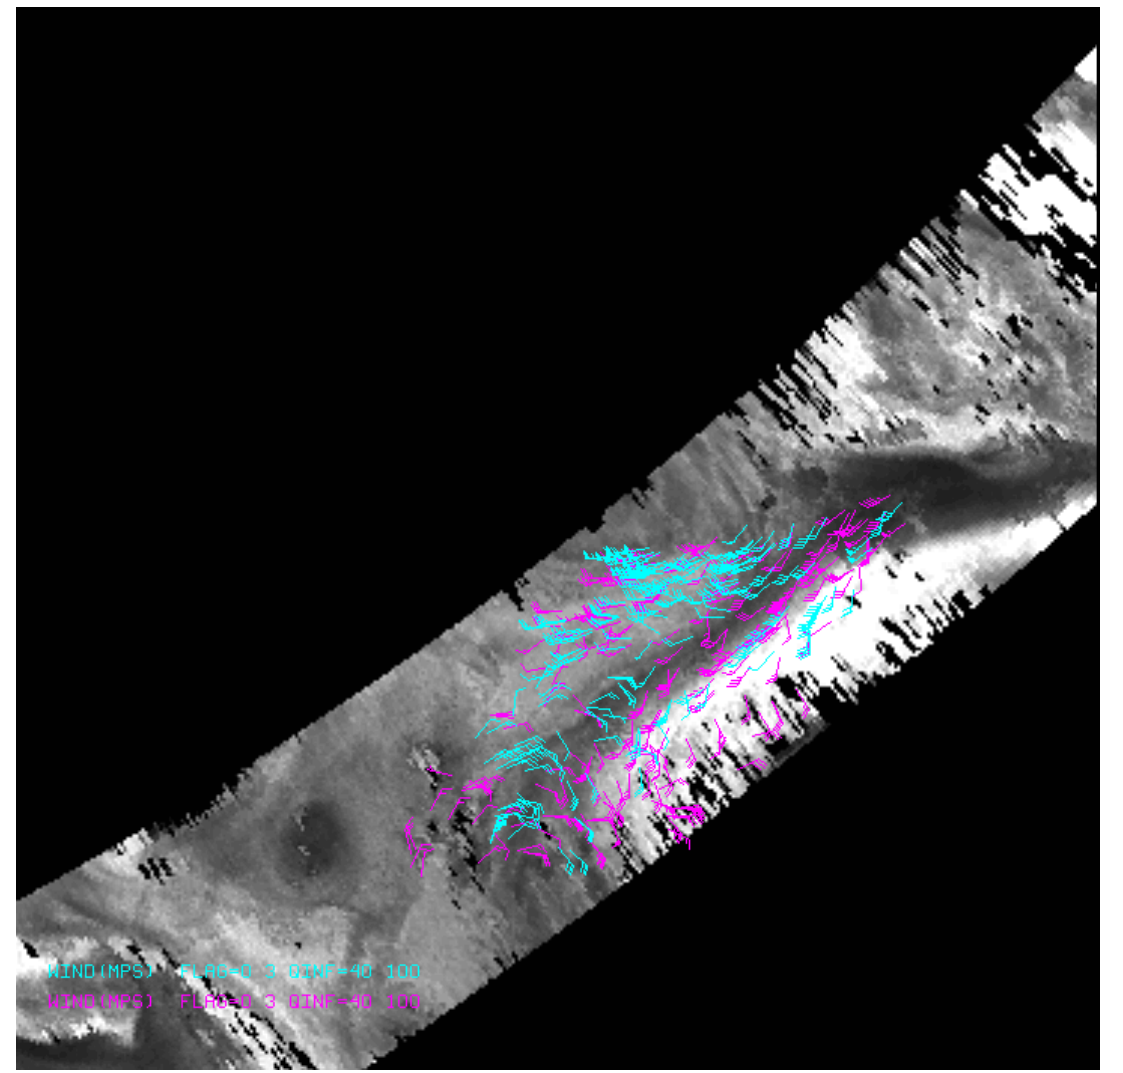
Figure 4. AIRS retrieval atmospheric motion vectors (AMVs) over a 400 hPa AIRS retrieved moisture field from 20 July 2012 0551 UTC. The North Pole is in the center of the picture, with Greenland in the lower-left region (not visible). These wind barbs are all moisture and ozone tracked AMVs color- coded by pressure level: cyan 400 to 699 hPa; magenta above 399